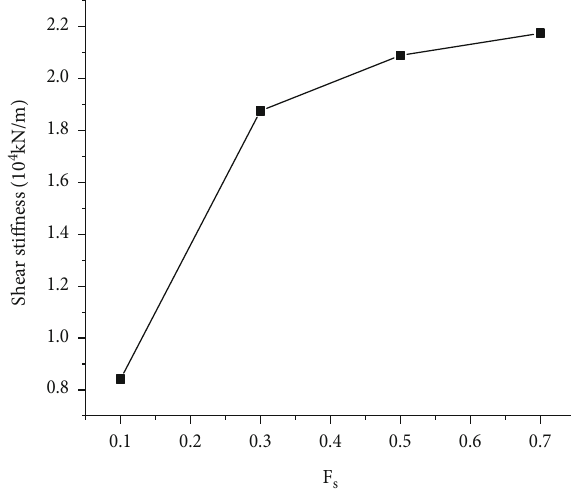
ff s and shear sti